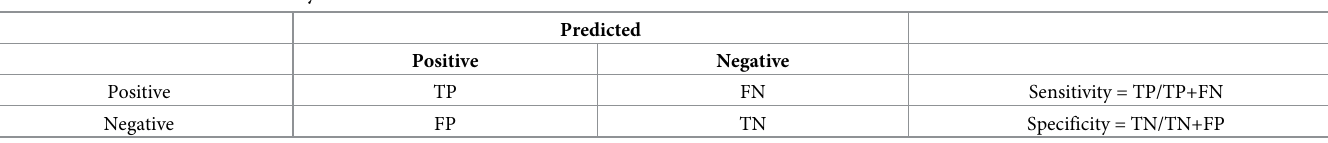
Table 1. Confusion matrix for a binary